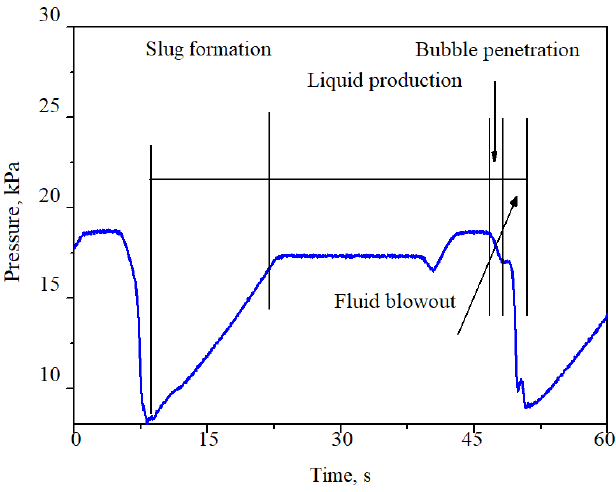
Figure 2. Measured pressure at riser-base during severe slugging ( U GS = 0.08 m/s and U LS = 0.09 m/s).